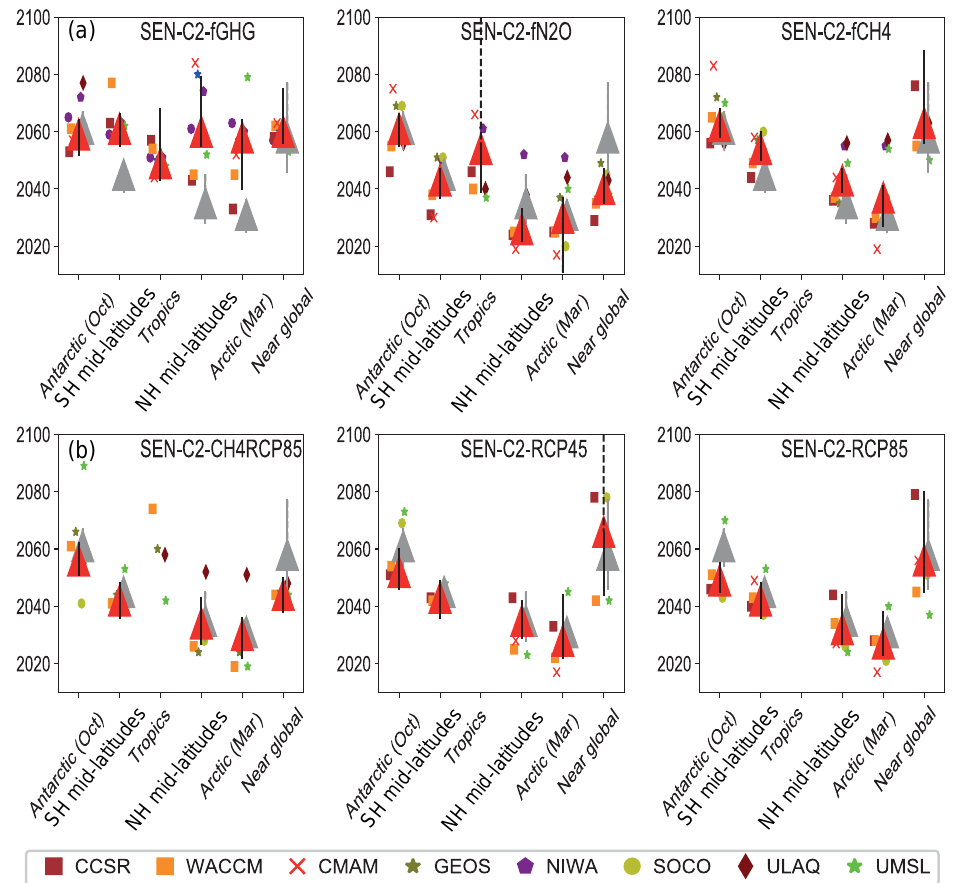
Figure 12. Estimated MMM1S return dates (red triangles) from stratospheric column ozone time series for (a) SEN-C2-fGHG, SEN-C2- fN2O, and SEN-C2-fCH4 and (b) SEN-C2-CH4RCP85, SEN-C2-RCP45, and SEN-C2-RCP85. Estimated uncertainties are shown with vertical black lines. Grey triangles indicate SCO return dates from REF-C2 (Fig. 4). Estimates for individual models are shown with coloured dots. Points with return dates (and uncertainties) that are greater than year 2100 are not